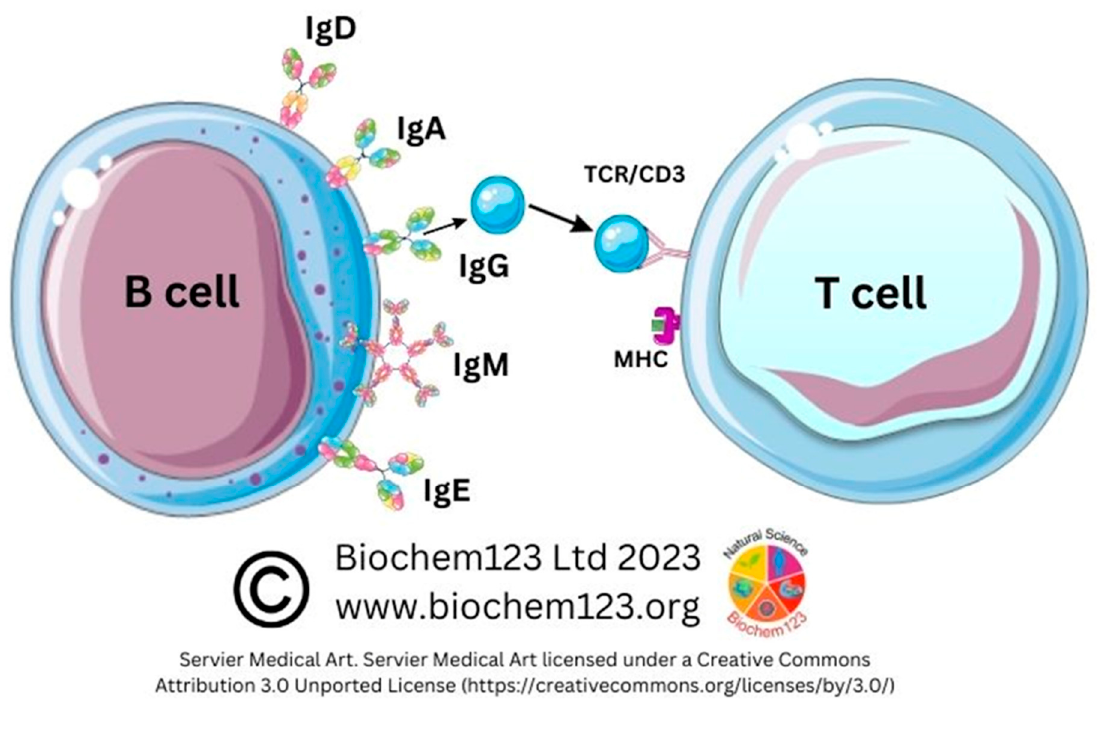
Figure 2. B cell and T cell interactions.